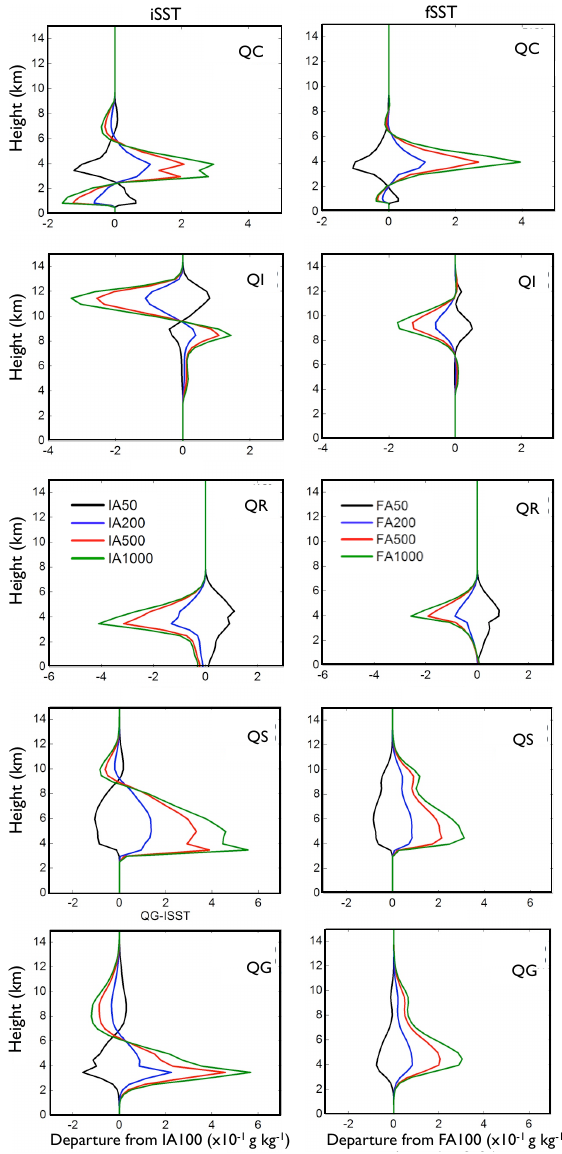
Fig. 6. Vertical profiles of departure from the control (IA100 and FA100) of the mixing ratio in 10 − 3 g kg − 1 of cloud liquid water (QC), rain water (QR), cloud ice (QI), snow (QS), and graupel (QG) for interactive (left panels) and fixed (right panels) SSTs.